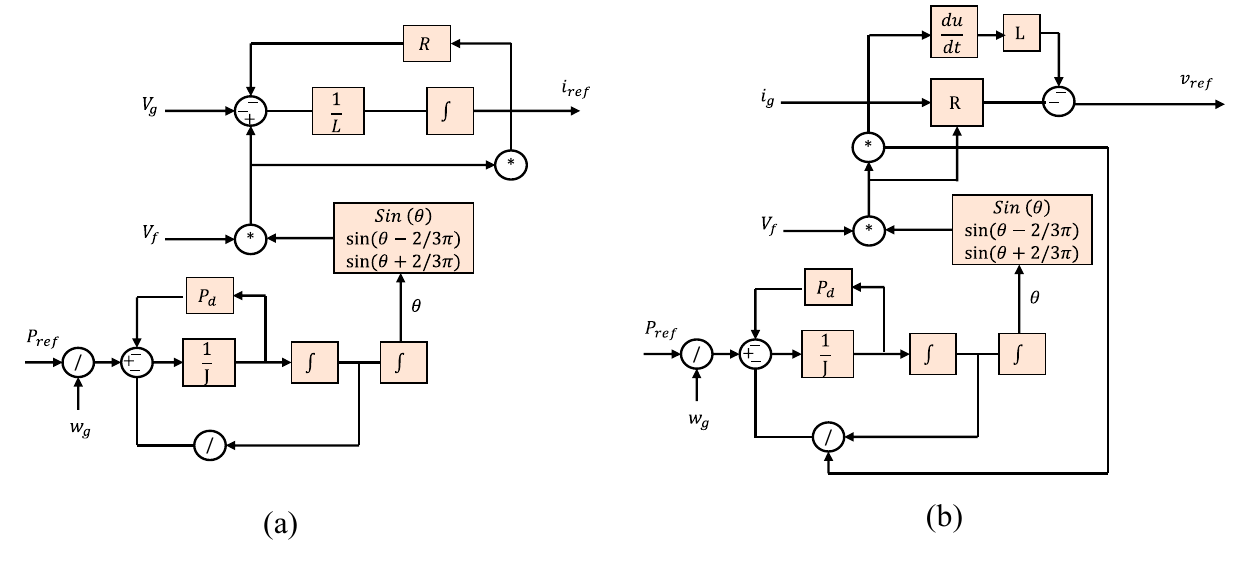
Figure 18. High-order VSG models: ( a ) voltage-to-current model, and ( b ) current-to-voltage model [42,44].